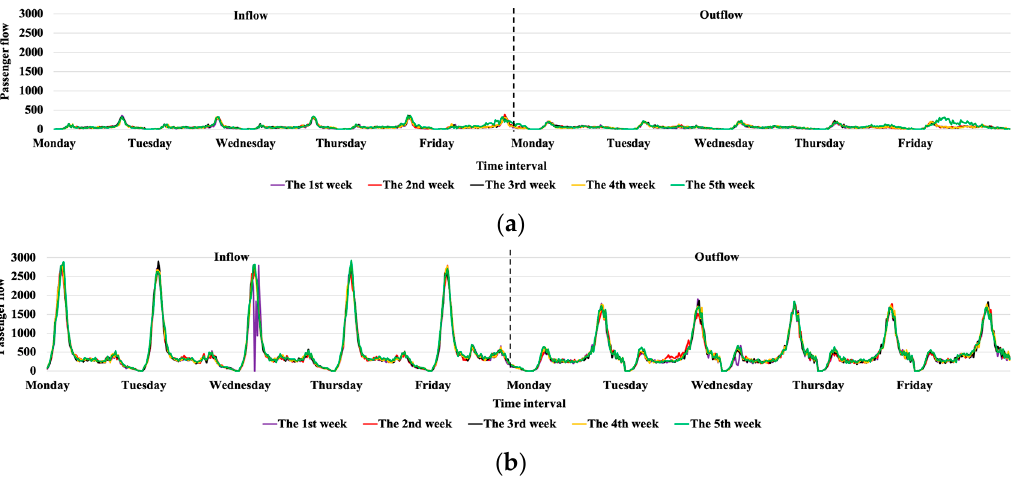
Figure 4. Stations’ passenger flow in the Xiamen BRT and the Beijing metro. ( a ) Five weekly inflow and outflow at 1st Wharf Station in the Xiamen BRT. ( b ) Five weekly inflow and outflow at No.1 Station in the Beijing metro.